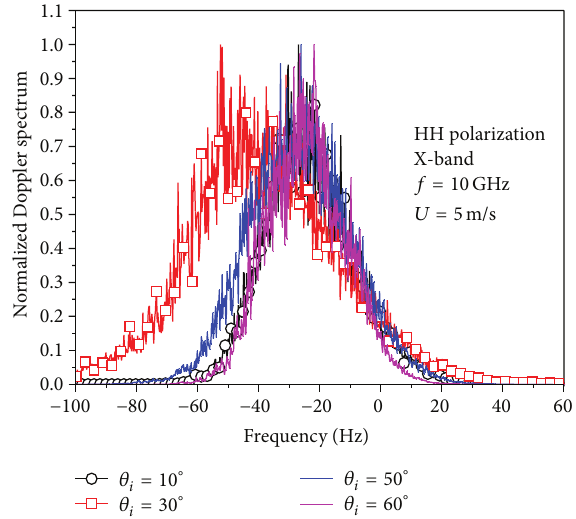
Figure 6: Doppler spectra of different incident angle.